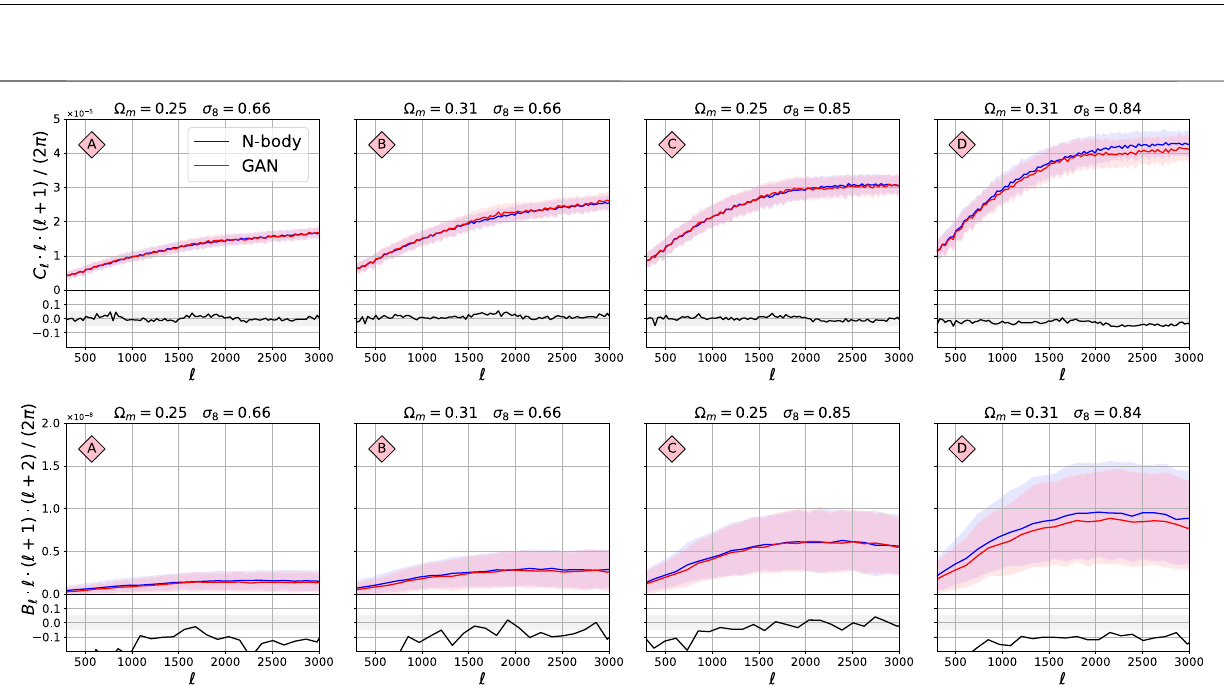
Frontiers in Arti fi cial Intelligence |